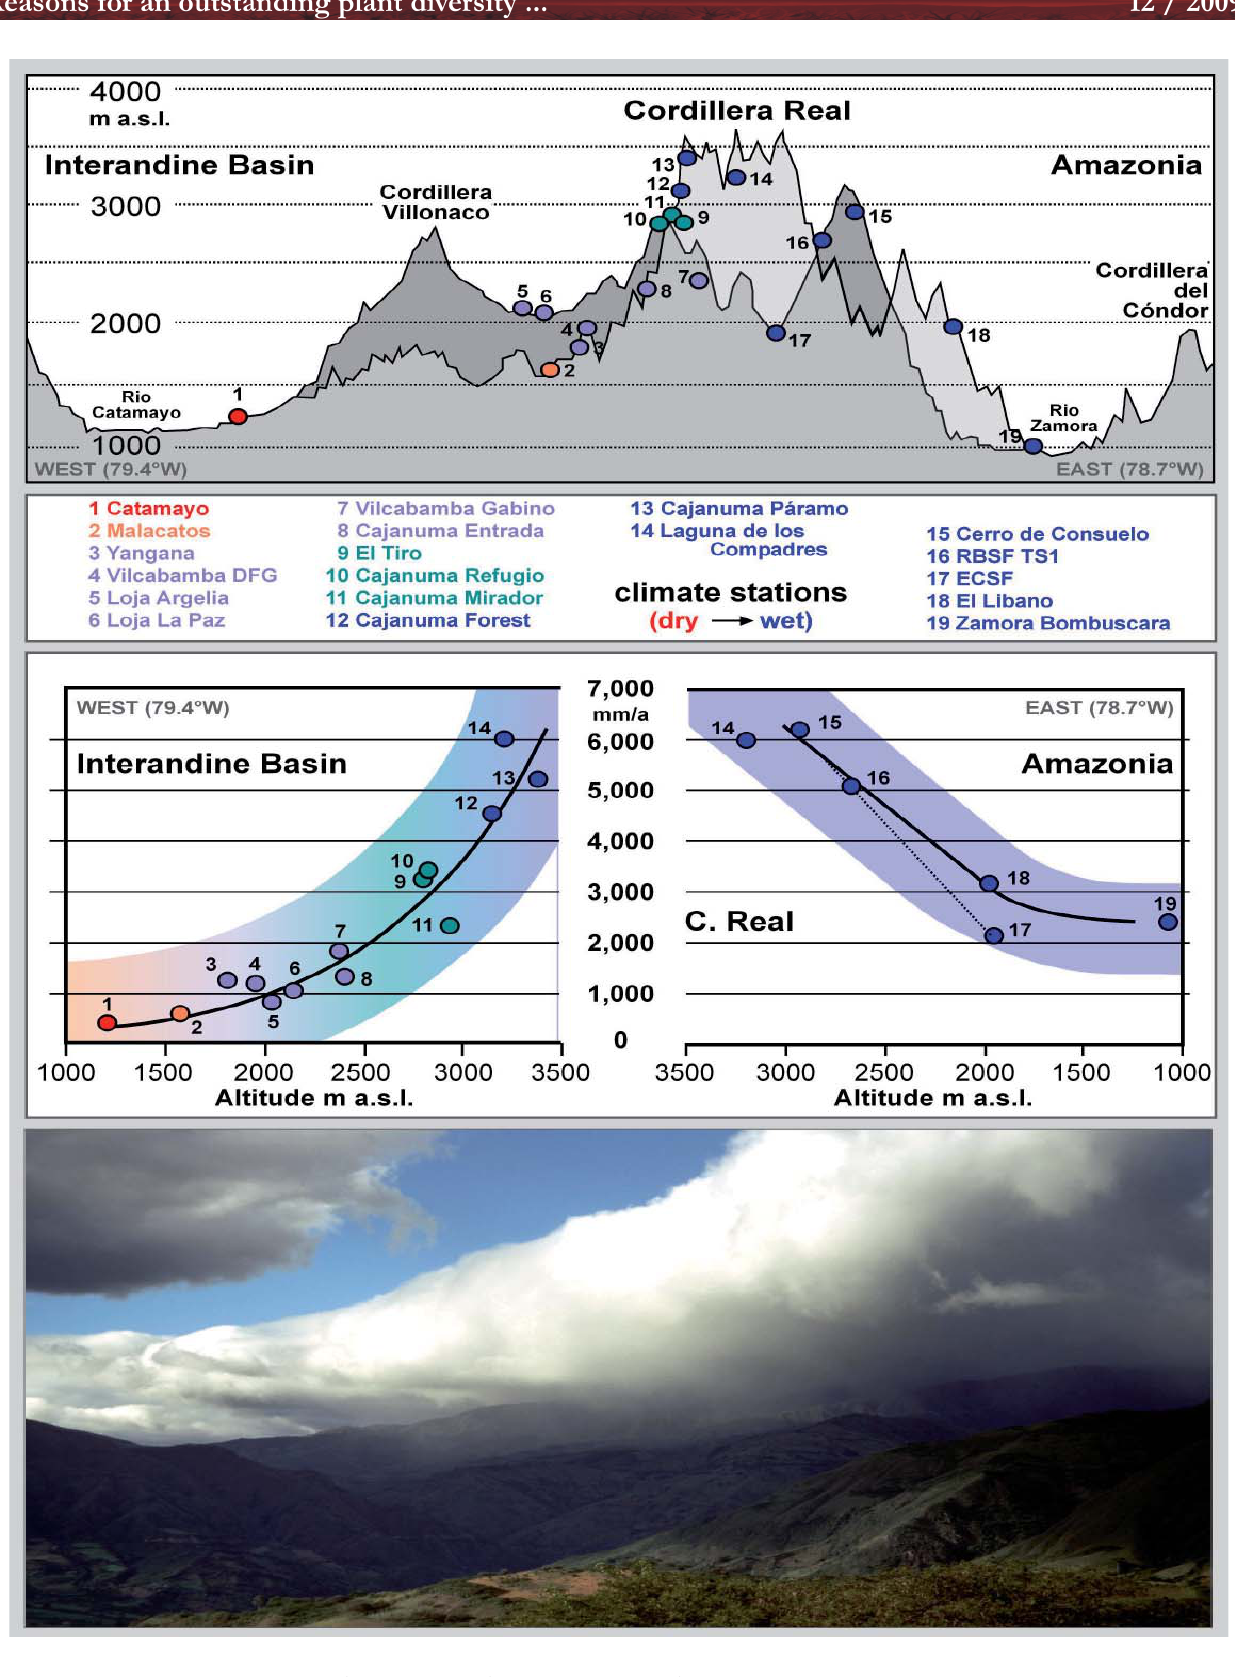
Figure 10: Precipitation gradients east and west of the Cordillera Real (Source: various Figures in Emck 2007, modified) and westward spill-over of the frequent foehn cloud over the crest line (photo: P.